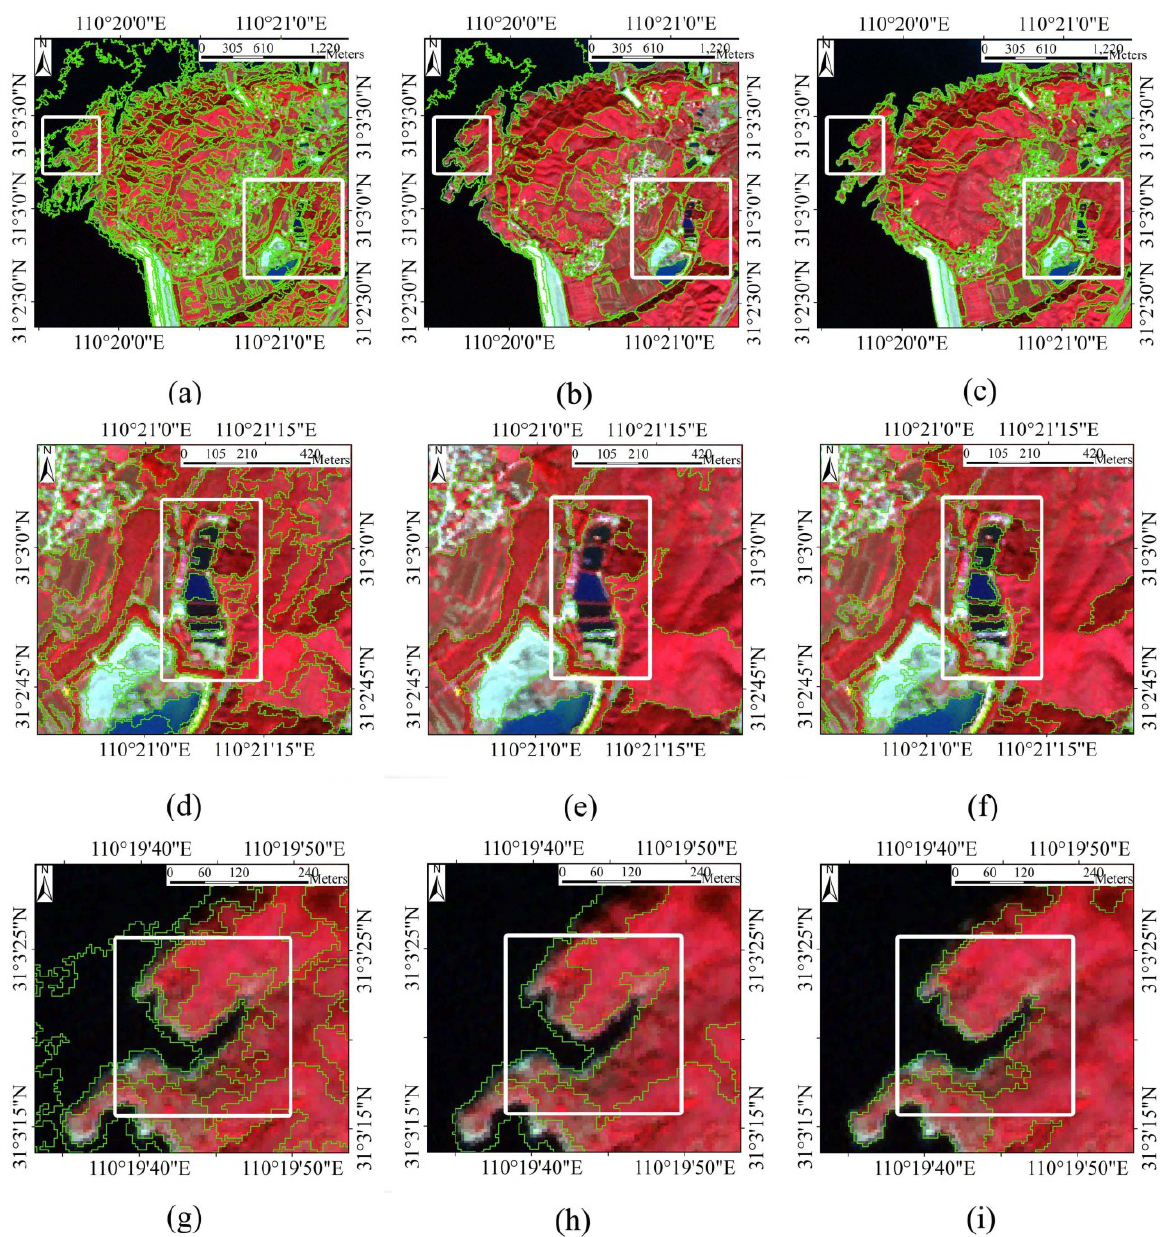
Figure 12. Comparison of the proposed algorithm and eCognition segmentation applied to R3. Images ( a , b ) are the results of the eCognition segmentation with scale parameters set to 200 and 700, respectively. Image ( c ) is the result of the proposed segmentation with ε, T and MC set to 0.1, 100 and 55, respectively. Images ( d – f ) show a zoomed-in area of ( a – c ). Images ( g – i ) show another zoomed-in area of ( a – c ). Their corresponding areas are showed in the white rectangles in ( a – c